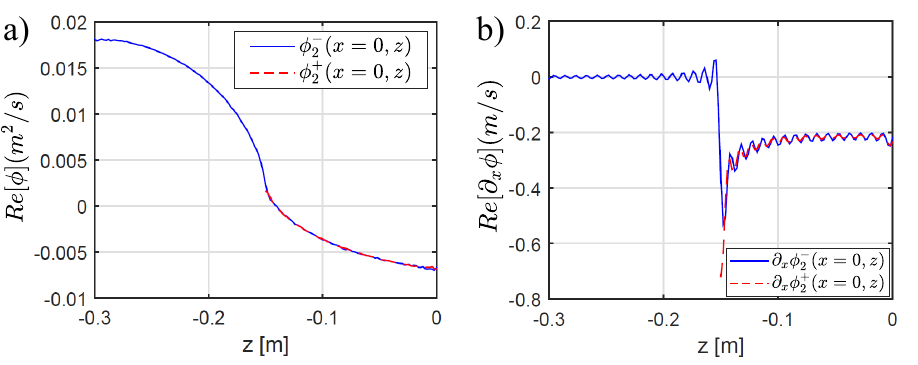
Figure 8. ( a ) Vertical profile at x = 0 of the velocity potential at the second order φ 2 ( 0, z ) . ( b ) Vertical profile at x = 0 of the horizontal velocity at the first-order ∂ x φ 2 ( 0, z ) .